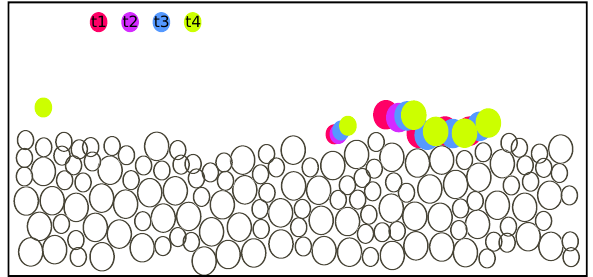
Figure 3. Schematic side view of the experiment showing an ex- ample of a collective motion event, sampled at four different times during the event. Black circles are outlines of non-moving particles; colors correspond to particles that are displaced actively during the event and are color coded according to their position at the time step ( t 1 , t 2 , etc.) as shown in the figure. At t 1 only two particles are mov- ing. The large particle collides with three particles on the bed at t 2 , and these three particles are displaced at t 3 and t 4 . The four large particles would be classified as moving together collectively.